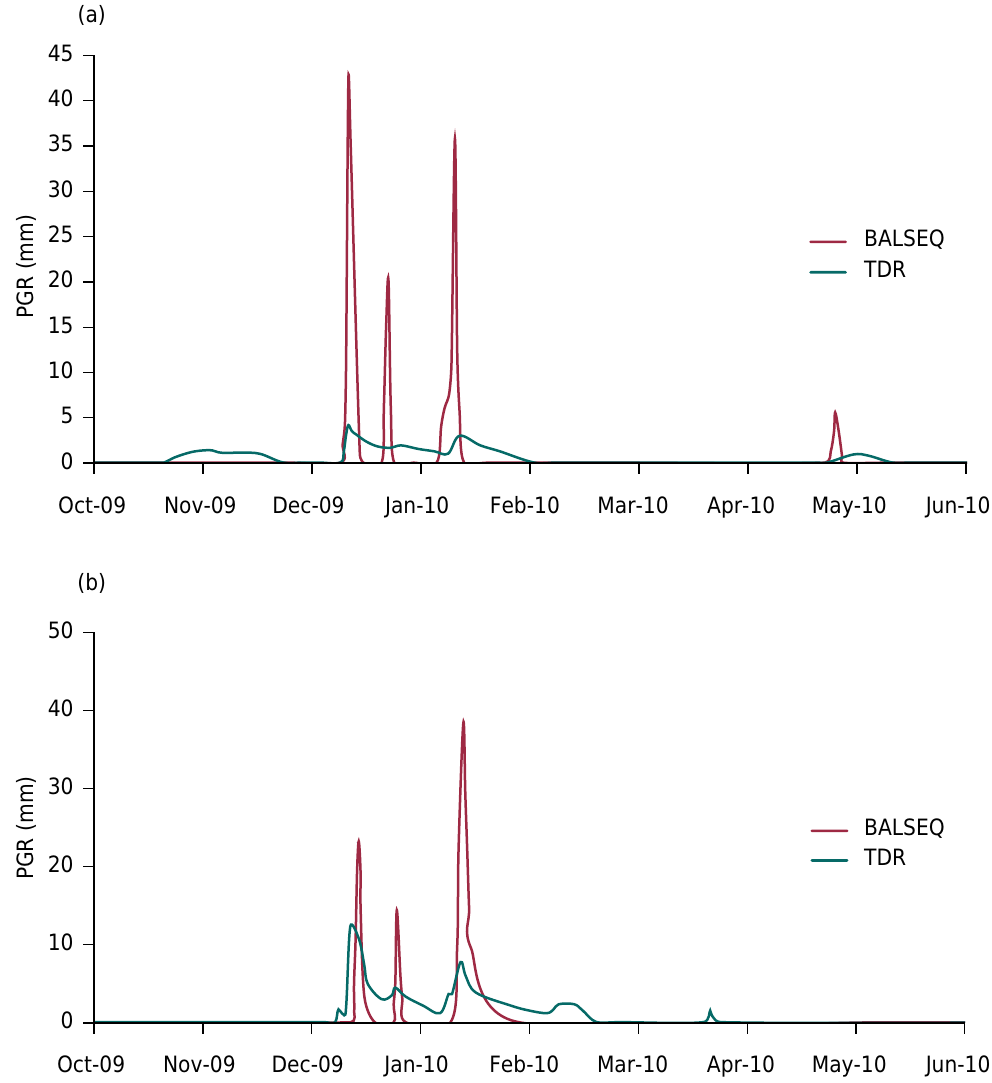
Figure 6. Comparison between recharge calculated with the BALSEQ model and recharge measured with the sensor in a conventional coffee plantation (a) and an agroforestry system (b) (PGR = potential groundwater recharge; Rp = potential recharge with BALSEQ; R sensor = recharge with the TDR